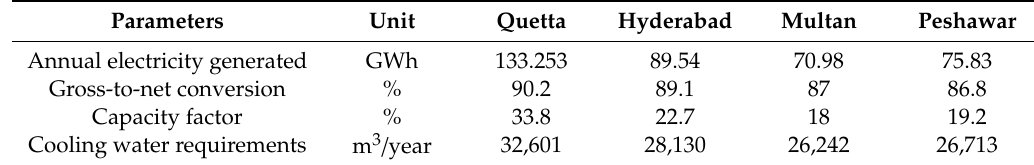
Figure 14. Electricity production by the 50 MWe PT plant with dry cooling for different regions. Table 6. Performance parameters of the 50 MWe PT plant with air cooling.